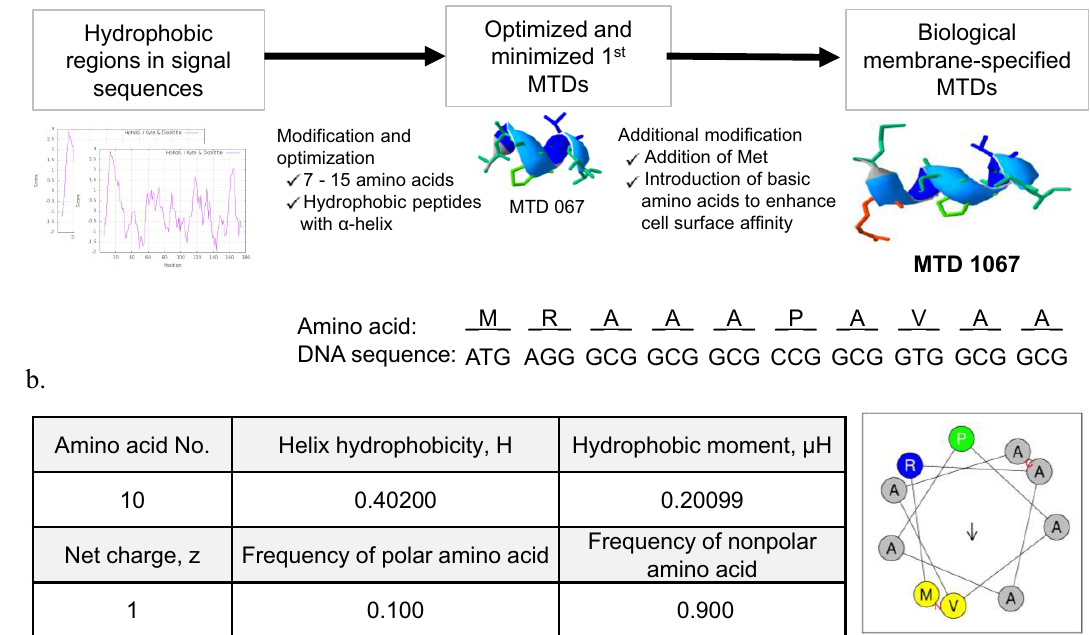
Figure 1. Physicochemical properties of MTD 1067. ( a ) Optimization and modification of synthetic MTD peptides designed based on hydrophobic regions in signal peptide sequences. MTD 1067 was modified from one of the first-generation MTDs, MTD 067 (AAAPAVAA) to increase biological membrane accessibility and permeability 30‚58 . The first generation of synthetic MTDs was developed by modifying the hydrophobic region in the signal sequences of various proteins to contain non-polar amino acids, such as alanine, valine, leucine, isoleucine, and proline, in different combinations to increase affinity with the hydrophobic lipid bilayer of the intracellular plasma membrane. Subsequently, positively charged hydrophilic amino acids, such as arginine, histidine, and lysine, were additionally introduced into the conventional hydrophobic MTDs to increase the accessibility of peptides to the negatively charged surface of the cell membrane. The N-terminal was also modified to contain methionine, which is the universal start codon in the signal peptide. The secondary structure of MTD 1067 was predicted using a de novo peptide structure prediction tool, PEP-FOLD3. ( b ) Alpha helix structure and physicochemical properties of MTD 1067. The helix wheel property and secondary structure of MTD 1067 were analyzed using HELIQUEST (http:// heliq uest. ipmc. cnrs. fr/) 59 and PEP-FOLD 3.5 (https://